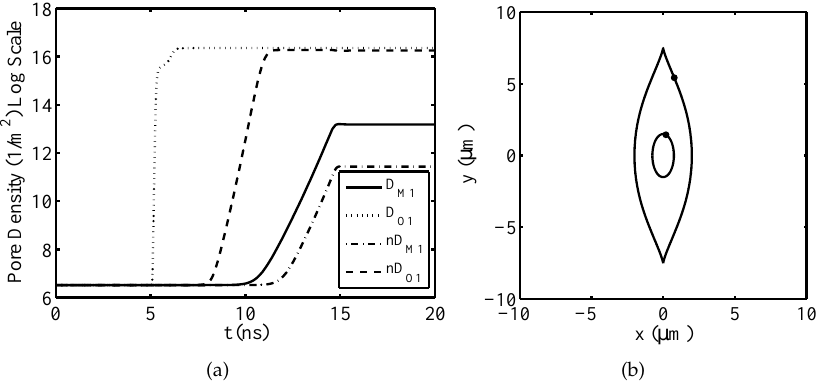
Figure 3. Isolated nucleated muscular cell—( a ) Temporal evolution of pore density for plasma and nuclear membranes at the angular placement θ = 75 ◦ evaluated using the dispersive and nondispersive model. ( b ) Angular placement θ = 75 ◦ on the